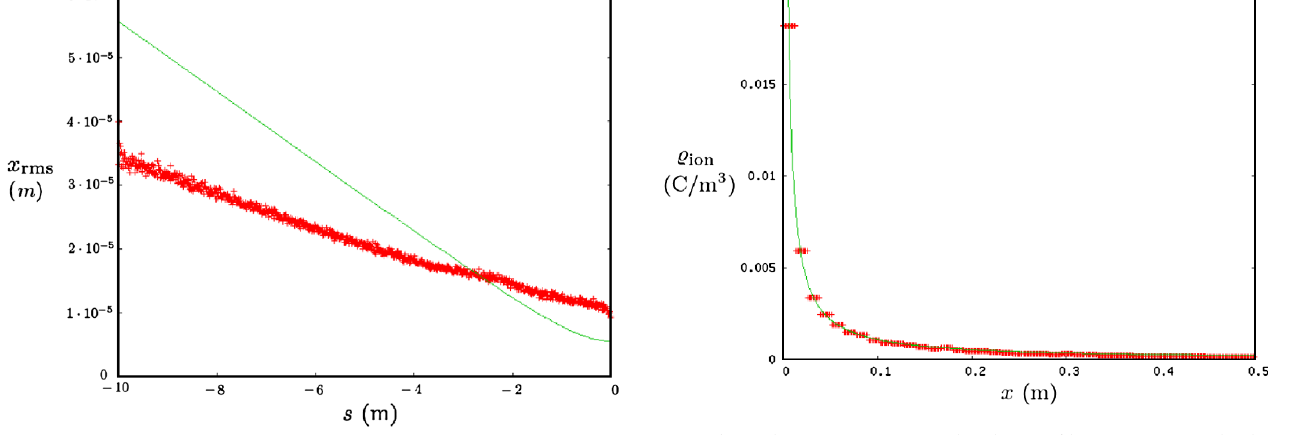
dard deviations as a function of longitudinal position in the 20 m beam